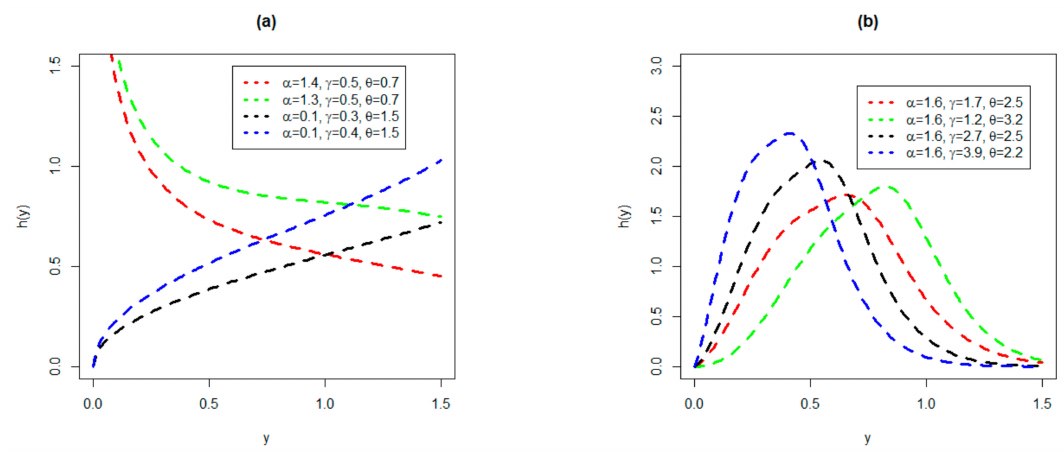
Figure 2. Plots of ( a ) increasing, and decreasing, and ( b ) unimodal HF h ( y ; α , ∆ ) of the NMEPA- Wei